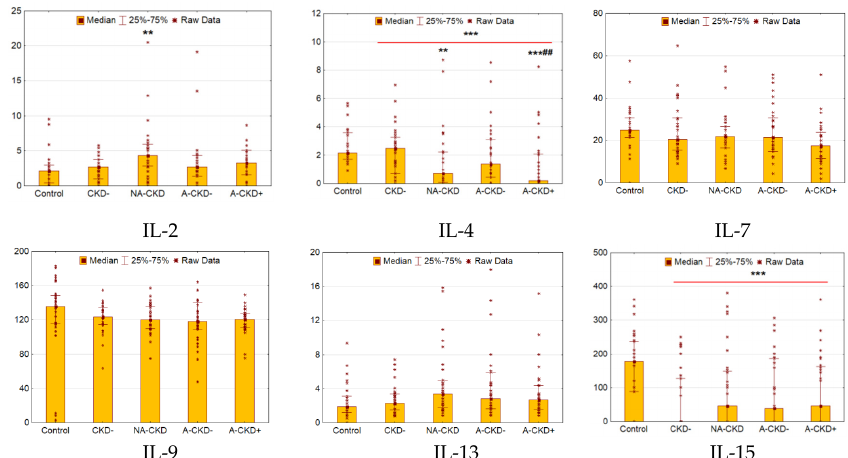
Figure 2. Serum concentrations of IL-2, IL-4, IL-7, IL-9, IL-13, and IL-15 (pg/mL). CKD − : patients